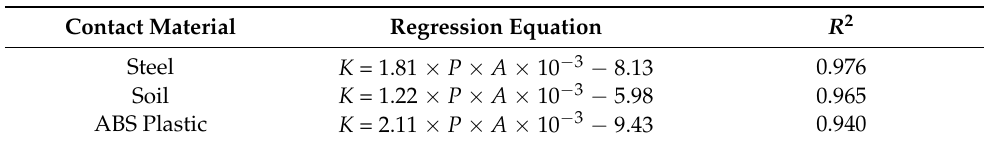
Table 5. Relationship between matrix loss and collision impact force of plug seedlings with different contact materials.